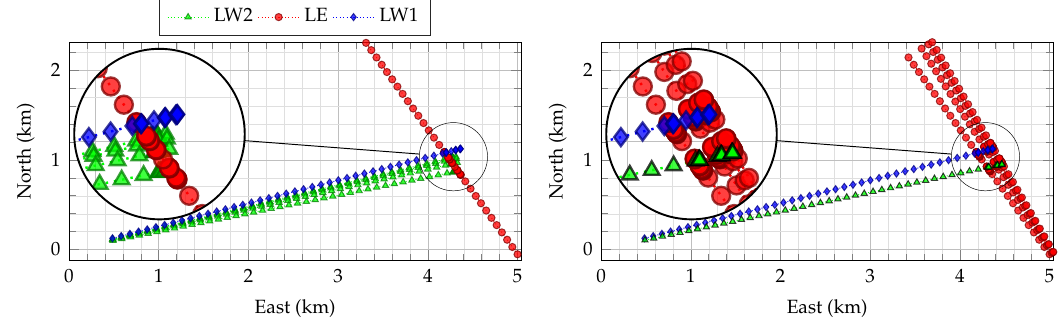
Figure 2. ( left ) North-South (N-S) scanning configuration; ( right ) East-West (E-W) scanning